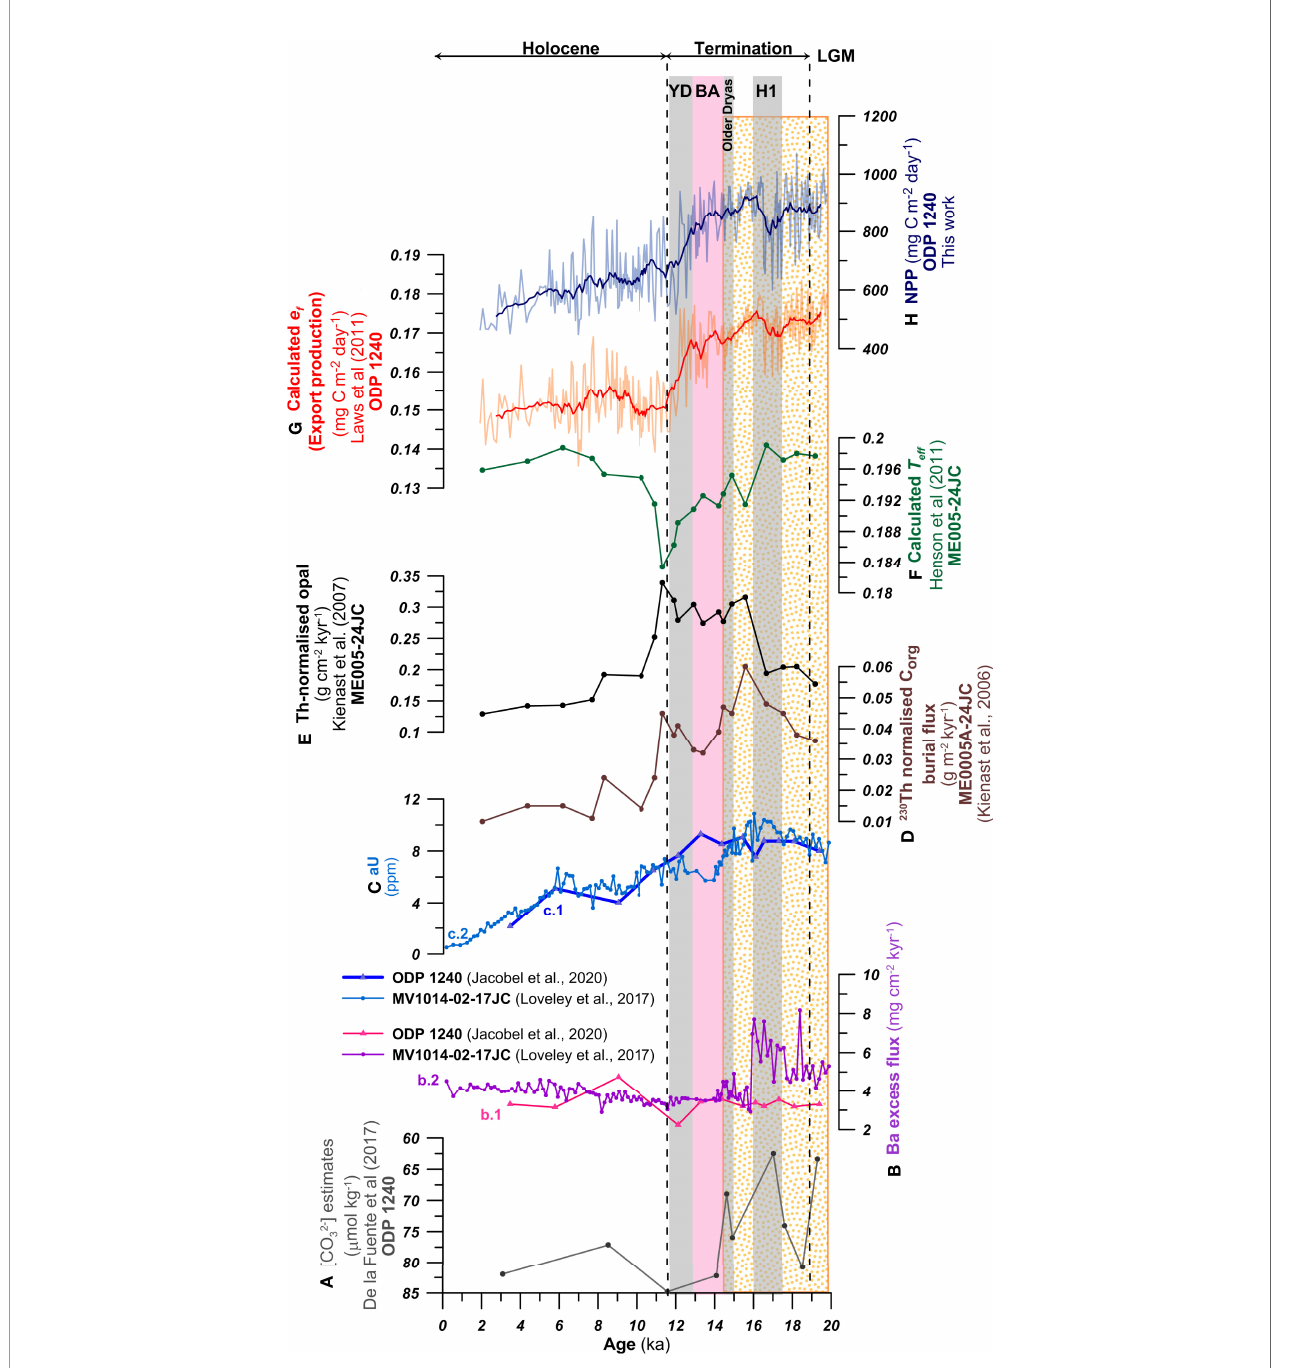
FIGURE 11 | Variations in the components of the biological pump since the late LGM at ODP Site 1240 and ME0005A-24JC. (A) ½ CO 2 − 3 (cid:2) estimates (µmol kg -1 ) (de la Fuente et al., 2017) -note the inverted scale-, (B) b.1: Ba excess fl ux (mg cm -2 ka -1 ) at ODP Site 1240 – triangles- (Jacobel et al., 2020) and b.2: Ba excess fl ux (mg cm -2 ka -1 ) at MV101402-17JC – dots- (Loveley et al., 2017); (C) c.1: authigenic uranium (aU, in ppm) at ODP Site 1240 – triangles- (Jacobel et al., 2020) and c.2: aU (in ppm) at MV101402-17JC – dots- (Loveley et al., 2017); (D) 230 Th-normalized organic carbon burial fl ux at ME0005A-24JC (g m -2 yr -1 ) (Kienast et al., 2006); (E) 230 Th-normalized opal fl ux (g m -2 yr -1 ) (Kienast et al., 2007); (F) Calculated transfer ef fi ciency ( T eff ) following Henson et al. (2012); (G) calculated export production ( e f ) using equation 5 (mg C m -2 day -1 ) following Laws et al. (2011) and with 13-point running average smoothing; (H) F. profunda -derived NPP (mg C m -2 day -1 , this work with 13-point running average smoothing). Black dashed lines indicate the late LGM, Termination I and the Holocene. Shaded areas indicate the Heinrich 1 (H1), Older Dryas, Bølling – Allerød (BA) and Younger Dryas (YD). The orange dotted interval highlights high NPP and export production, and low oxygenation of the